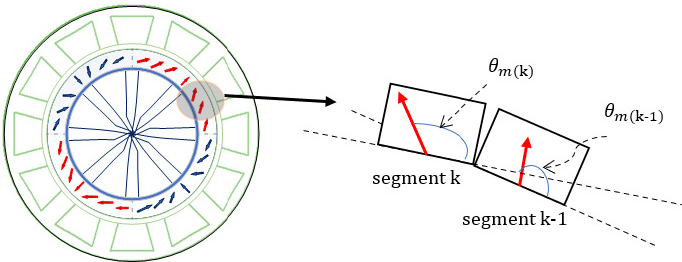
Figure 2. Rim Driven machine with progressive magnetization Halbach